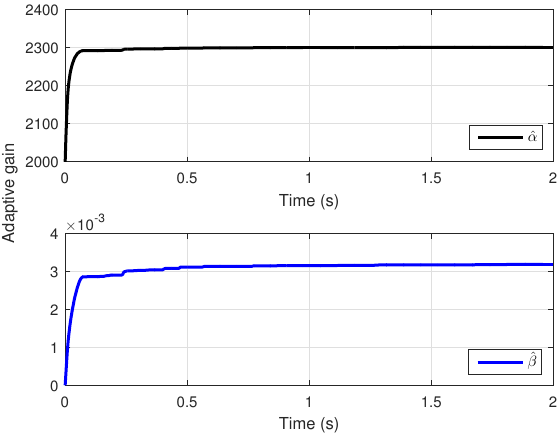
Figure 4. Adaptive gains of ITOSMC.